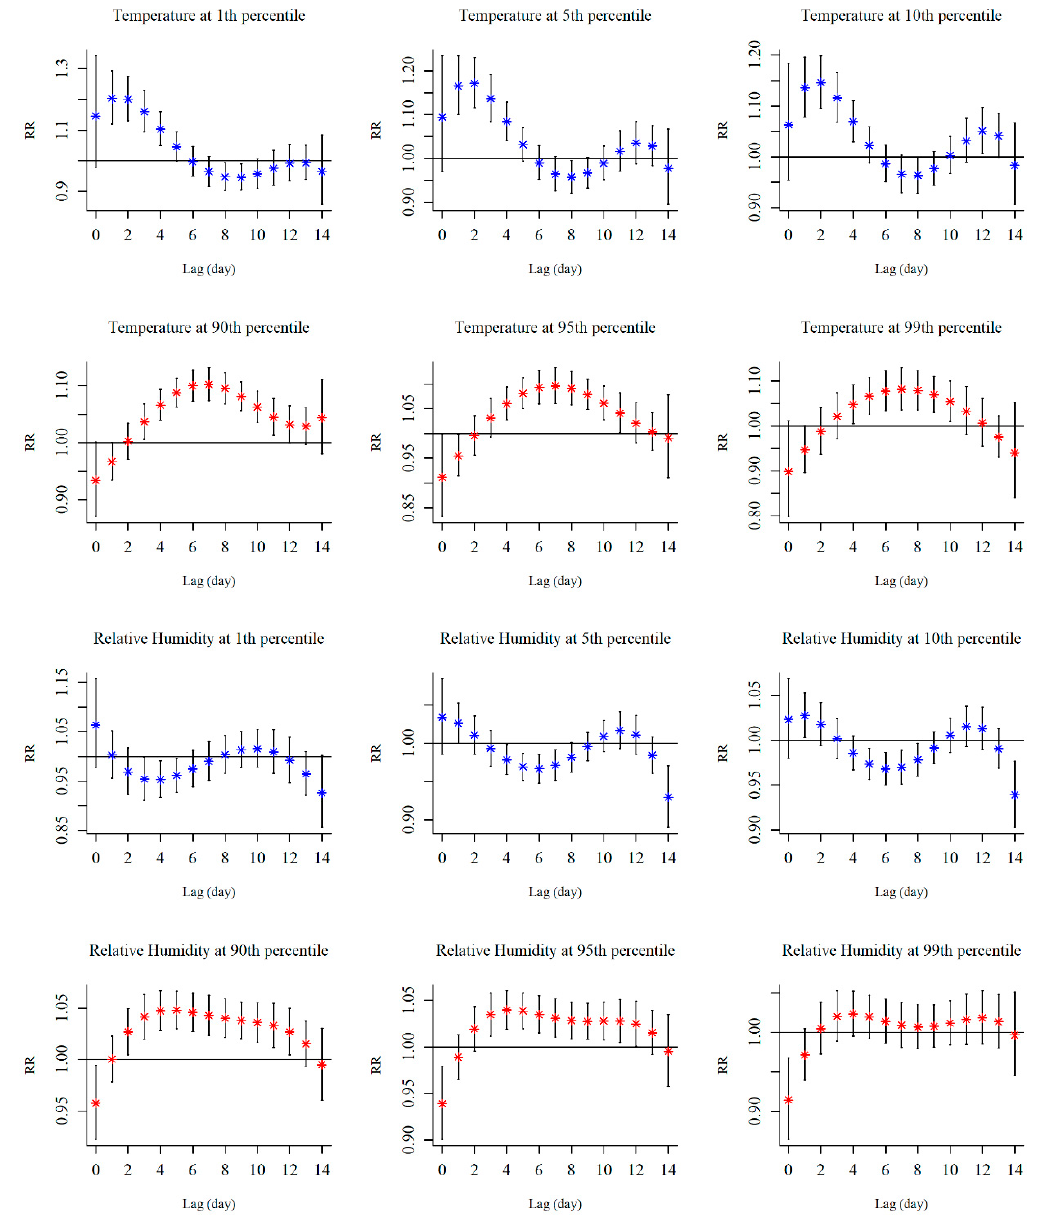
Figure 4. The distributed lagged effects of extreme ambient temperature and relative humidity on the incidence of HFMD at various lag days. The medium value of each variable was selected as the reference.